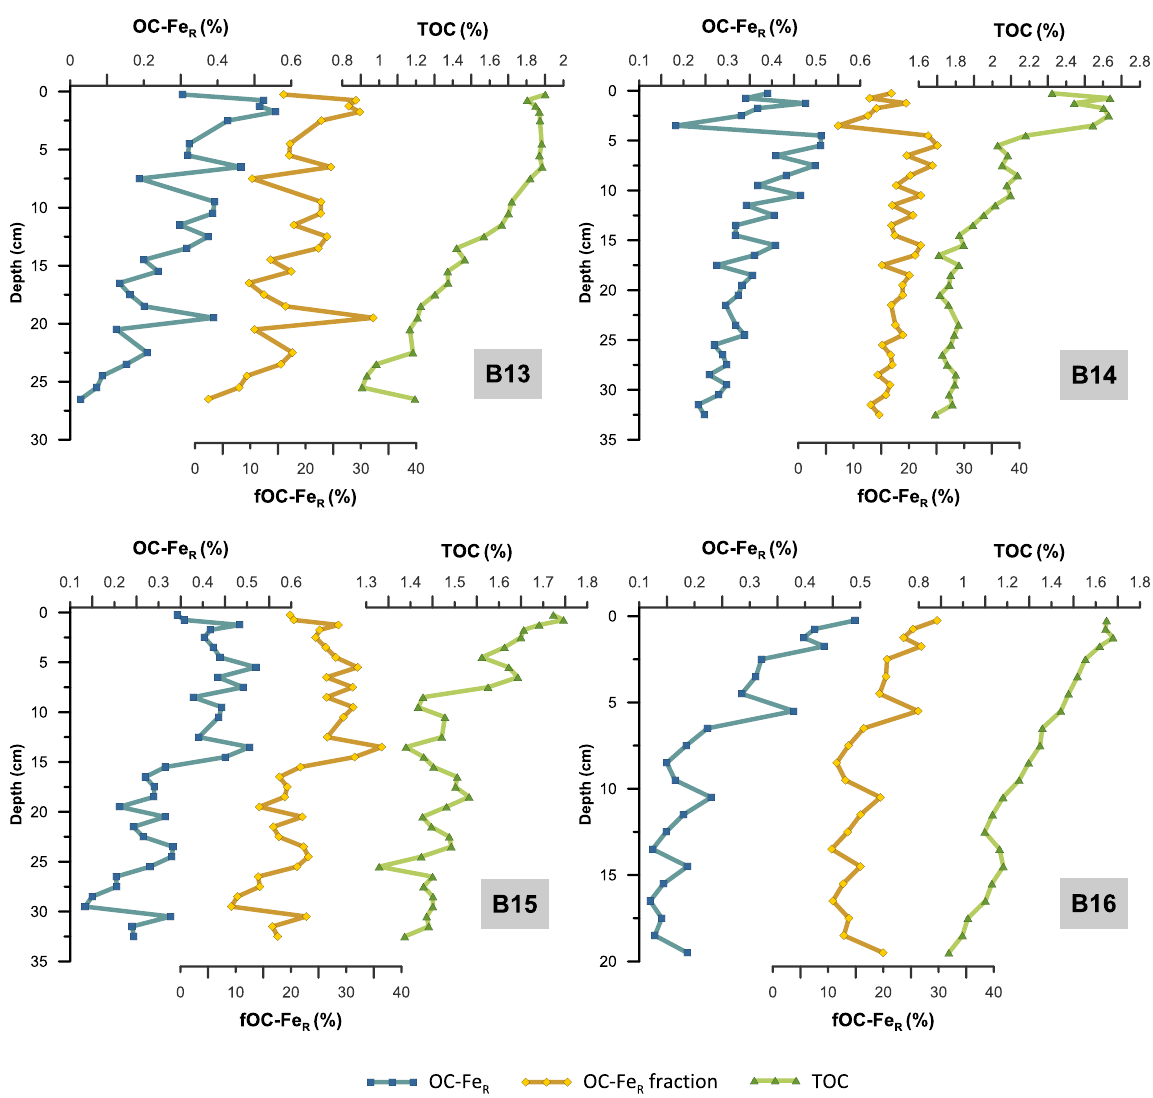
Fig. 4 Downcore pro fi les of total OC content bound to reactive iron (OC-Fe R ), the fraction of total organic carbon bound to reactive iron (fOC-Fe R ), and total organic carbon content (TOC). The gradual downcore decrease in all three parameters may indicate that sedimentary OC degradation also affects the OC bound to Fe R , even though fOC-Fe R values are still relatively high in the lower part of these Arctic sediment cores. Other factors than diagenetic processes, such as environmental change, OC, and allochthonous OC-Fe R input changes, probably also play a role during the time span investigated here. Note the different scale of the x -axis (sediment core depth) and y -axis (TOC) between each